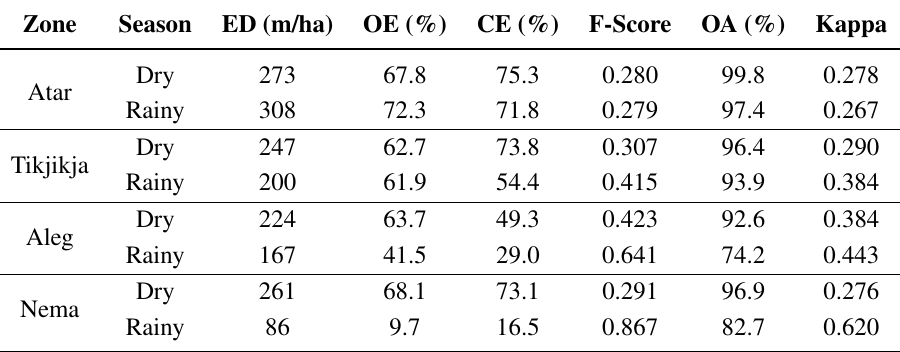
The dynamic greenness maps were further analyzed with the Pareto boundary method (Figure 6) at 1 km, 250 m and 100 m, corresponding to the spatial resolution of SPOT-VEGETATION, MODIS and PROBA-V. At 250 m, the unreachable region appears to have a substantial impact, accounting for up to 60% of the errors during the dry season. Its influence diminishes along with latitude during the rainy season. The variance of the Pareto boundary resulting from the uncertainties when superimposing the two grids is always below 0.01 and thus